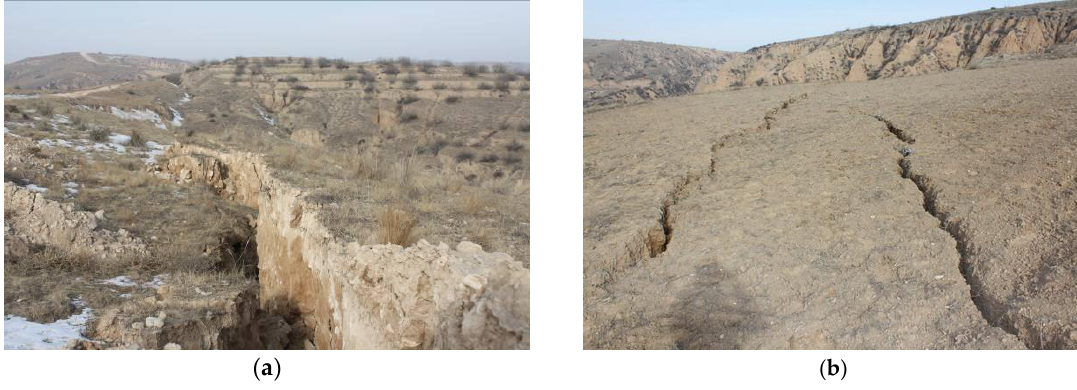
Figure 3. The ground surface is seriously damaged during SBCSM-S mining; ( a,b ) Mining-induced fractures. The ground surface is seriously damaged during SBCSM-S mining; Mining-induced